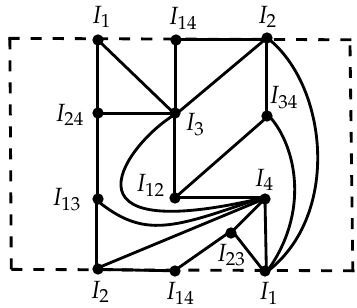
∪ 4 Figure 9. | U n | = 4 with | U ij ∪ U ( ij ) c | ≤ 2 for all U ij , U ( ij ) c ̸ = ∅ n = 1